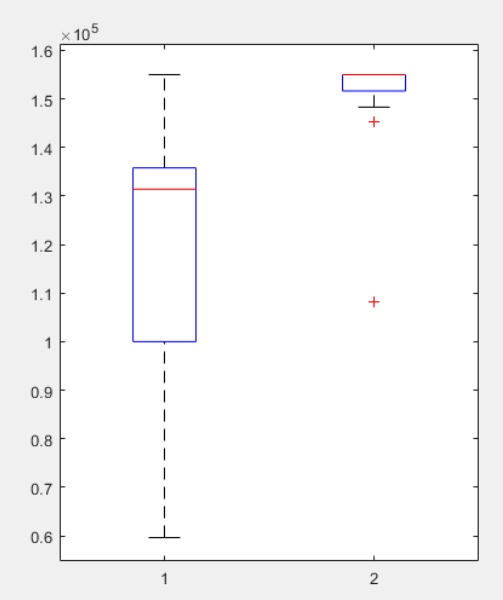
Figure 9. Boxplots of the fracture loads (number of cyclic loadings).